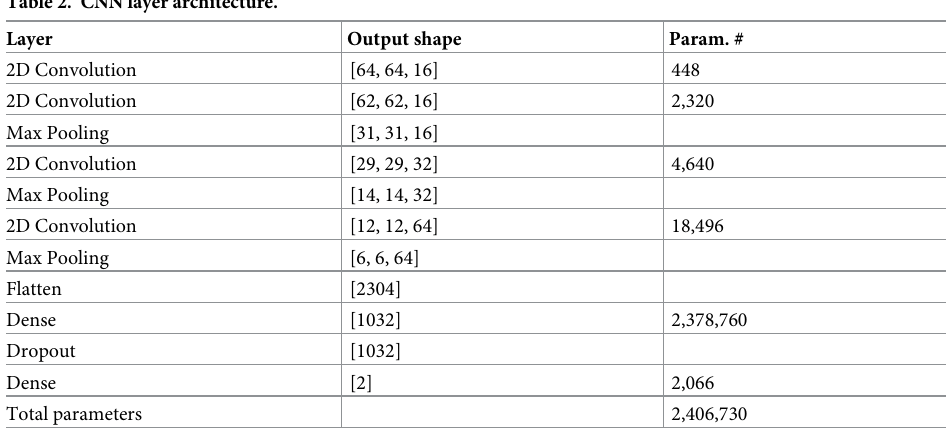
Table 2. CNN layer architecture.